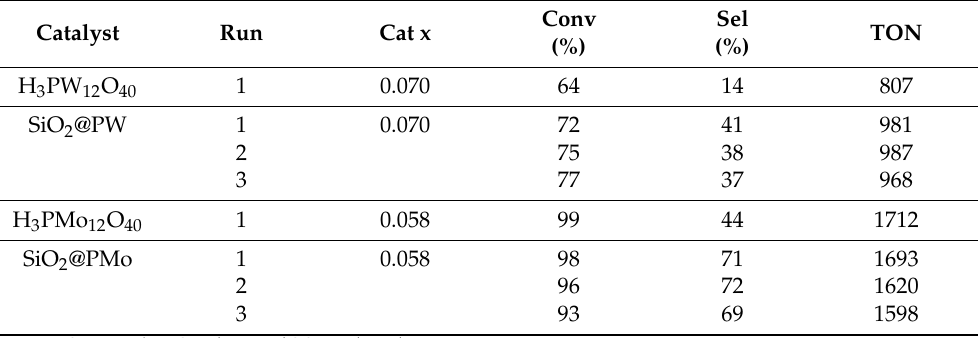
Figure 25. Schematic representation of POMs grafted on functionalized silica. Table 13. CO epoxidation into COE with heteropolyacids and corresponding anionic species from Figure 25.